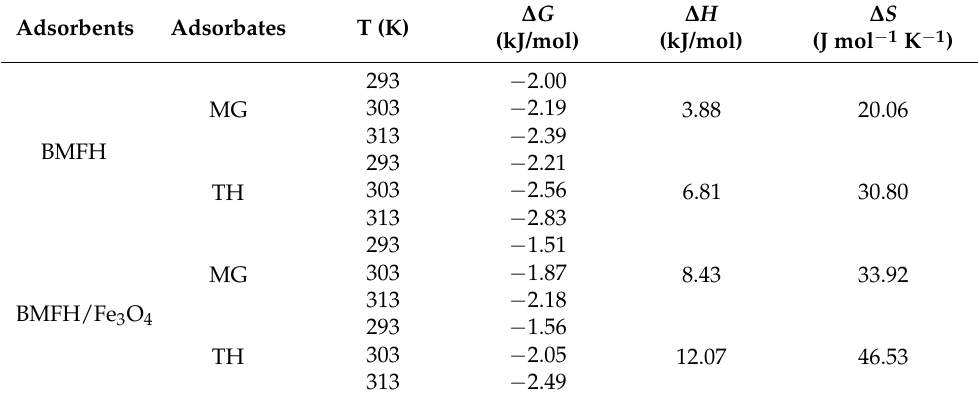
Figure 8. Effect of different temperatures on the adsorption capacities of ( A ) BMFH and ( B ) BMFH/Fe 3 O 4 for MG and TH. Table 4. Fitting adsorption thermodynamic parameters for MG and TH.